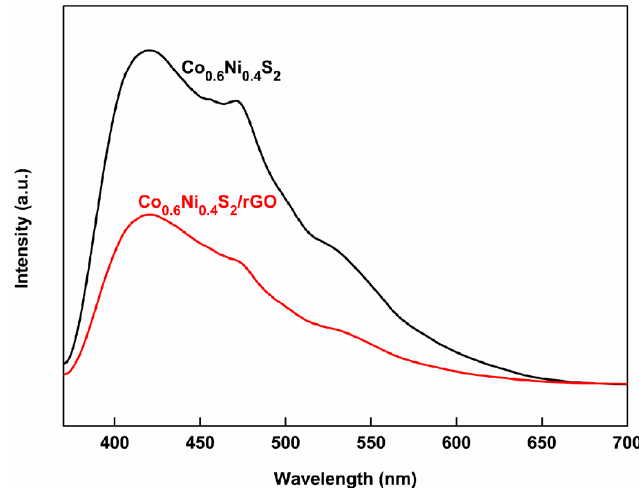
Figure 8. Photoluminescence spectra of Co 0.6 Ni 0.4 S 2 and Co 0.6 Ni 0.4 S 2 /rGO (excitation wavelength, 280 nm).